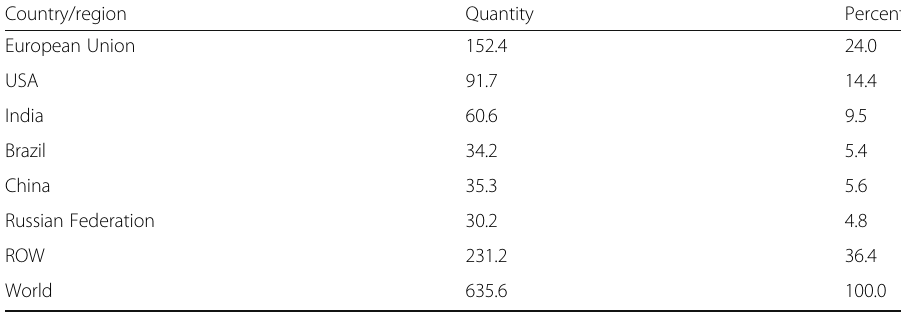
Table 1 Production of fresh cow ’ s milk by country or region in 2013 – (millions of tons)